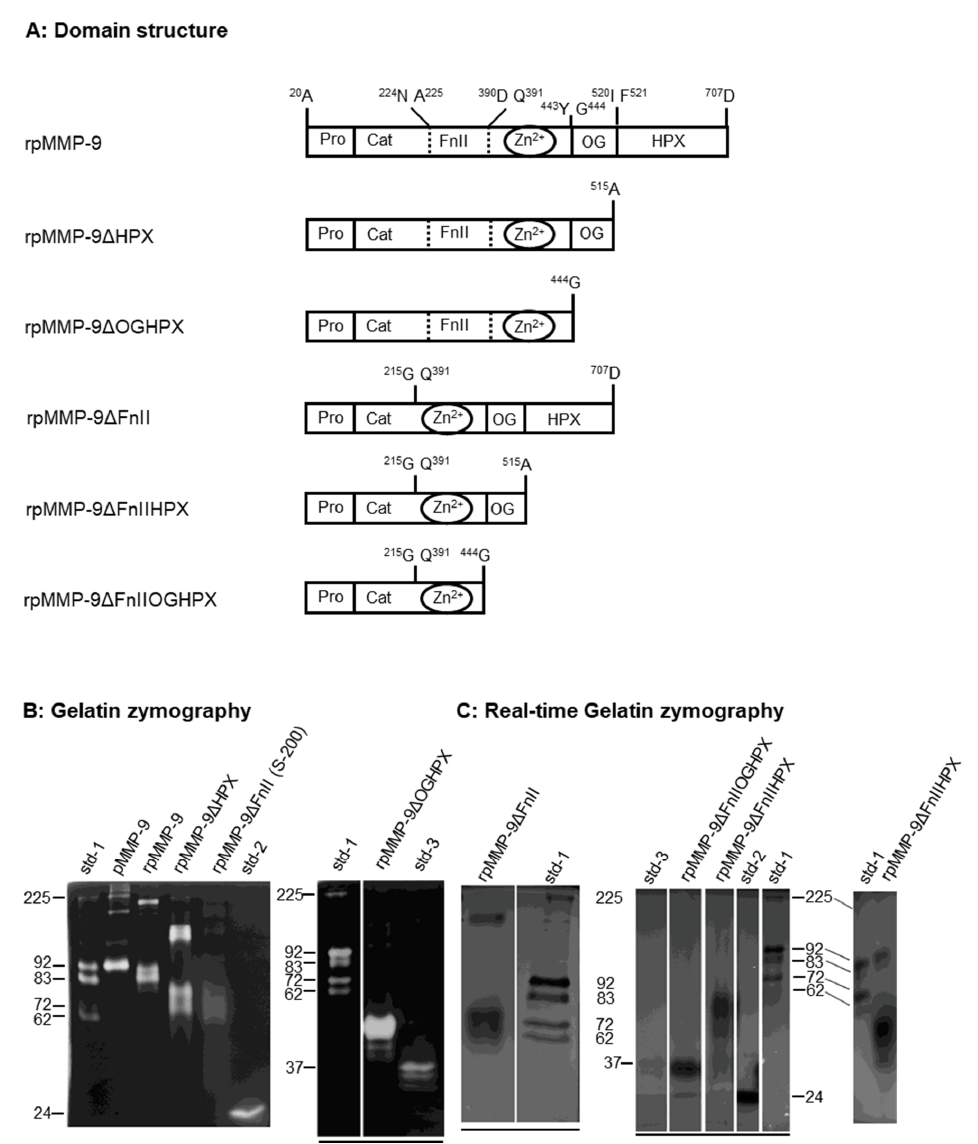
Figure 1. Schematic domain structure ( A ), gelatin zymography ( B ), and real-time gelatin zymography ( C ) of recombinant proMMP-9 variants. ( A ) At the top, the full-length proMMP-9 with its domains. Shown above in ( A ) is the numbering of the amino acids starting with the pre domain, which is cleaved off in the endoplasmatic reticulum, and the mature proenzyme, which starts at amino acid 20 and ends at amino acid 707. Shown also are the amino acids at the border of the FnII module and at the boarder of the OG and the HPX domain based on Vandooren et al. 2013 [28]. The five deletion variants with their C-terminal amino acid are shown. In the fibronectin-deleted variants, the amino acids that were linked together after the FnII deletion are shown. The different recombinant proMMP-9 (rpMMP-9) variants were produced in Sf9 and High Five insect cells with a baculoviral transfection system as described in the Materials and Methods. ( B ) The purified variants were applied to gelatin zymography, and the rpMMP-9ΔFnII variant was from the pooled fractions from a Sepharose S-200 column. Under these conditions, this variant contained mainly the monomeric variant. ( C ) Real-time gelatin zymography of crude media of the three ΔFnII-deleted variants. Standards in ( B , C ) are: std-1 (a mixture of MMP-9 (homodimer/homotrimer 225 kDa; monomeric pro 92 kDa; and active 83 kDa) from THP-1 cells and MMP-2 (pro 72 kDa; active 62 kDa) from skin fibroblasts; std-2 (trypsin 24 kDa); and std-3 (catalytic domain of MMP-9 containing the FnII repeats 37 kDa). A line under gels indicates that the samples are from the same gel, which was cut and pasted for clarity in